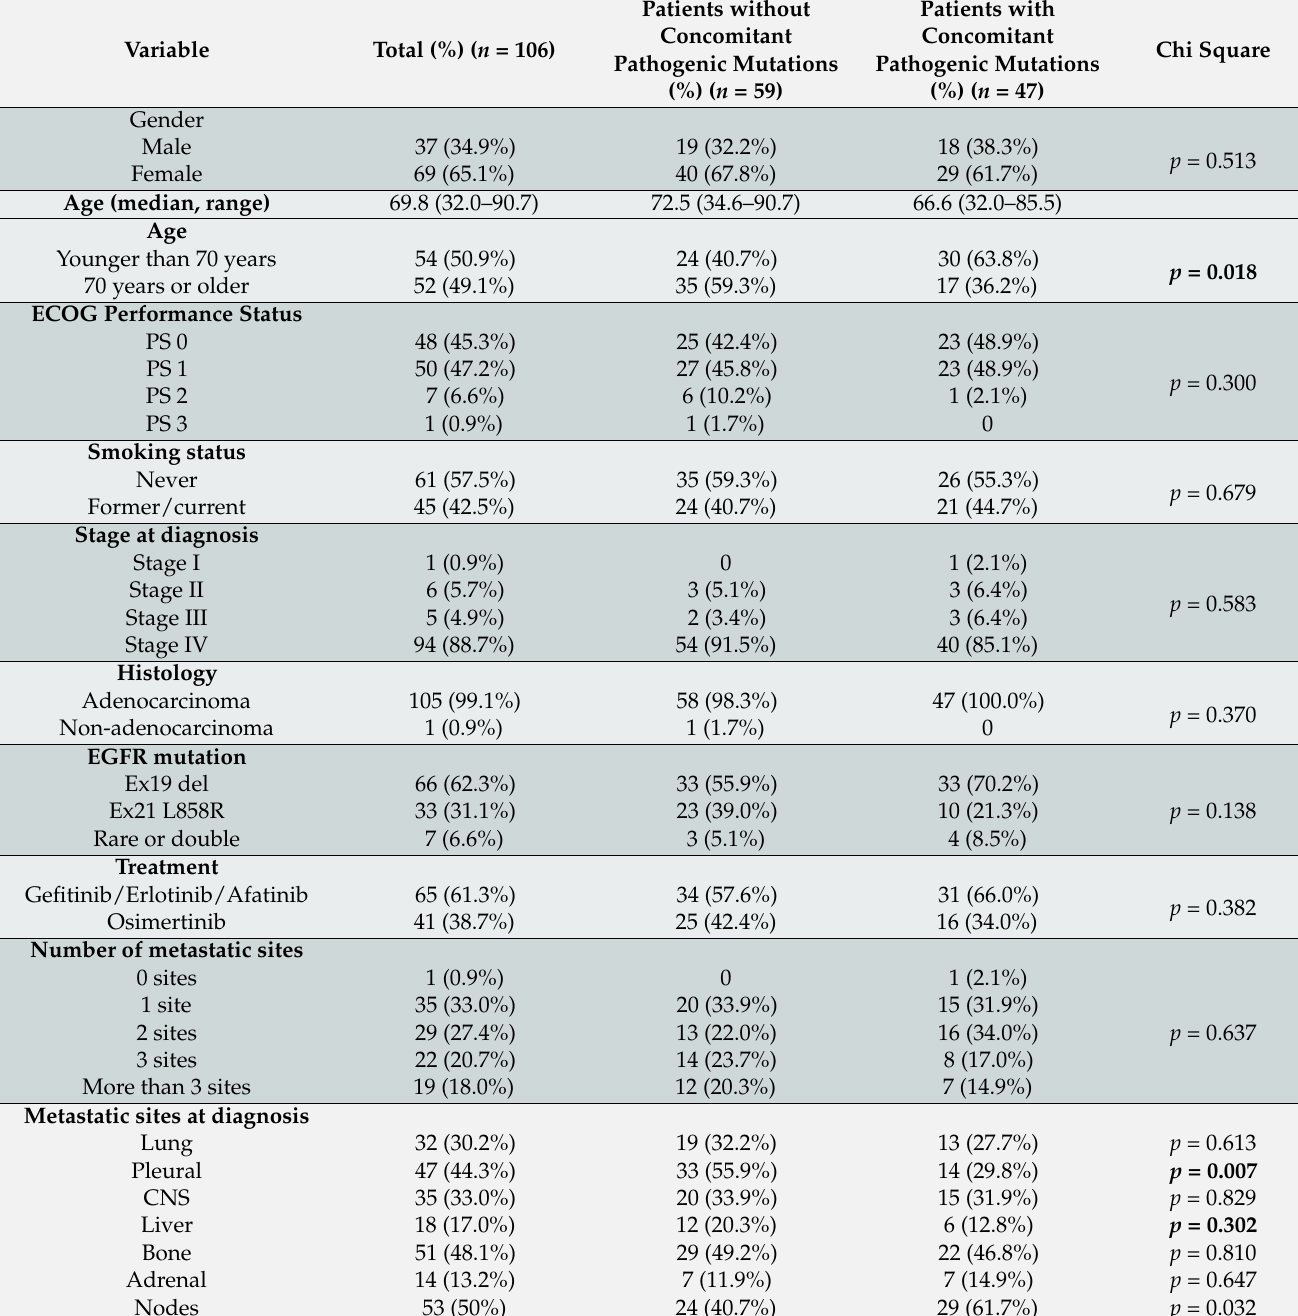
Table 1. Patient characteristics. ECOG: Eastern Cooperative Oncology Group; EGFR: Epidermal Growth Factor Receptor; Ex: exon; CNS: Central Nervous